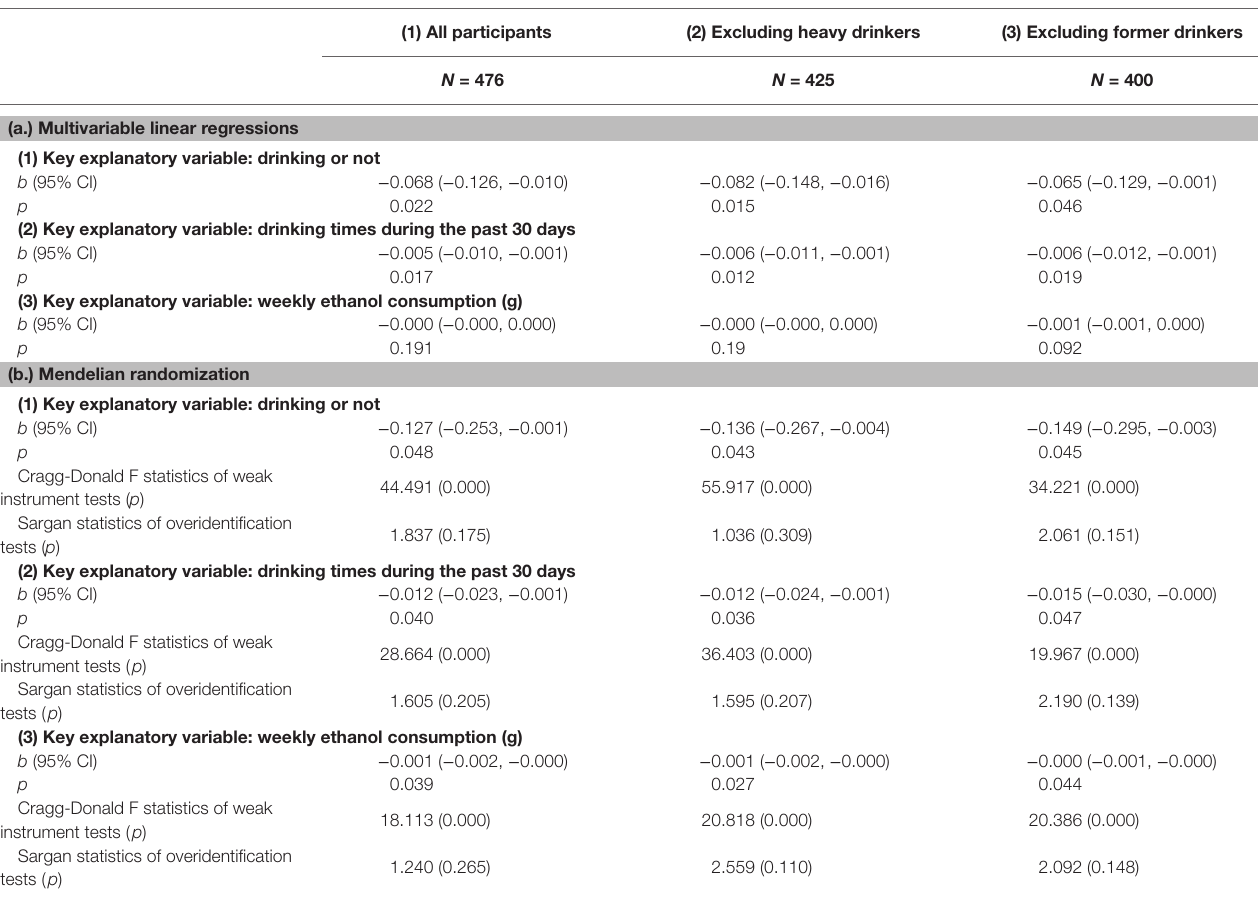
TABLE 2 | Effects of alcohol use on depression – OLS and 2SLS estimation